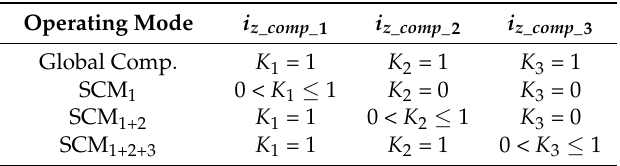
Table 2. Scale factor